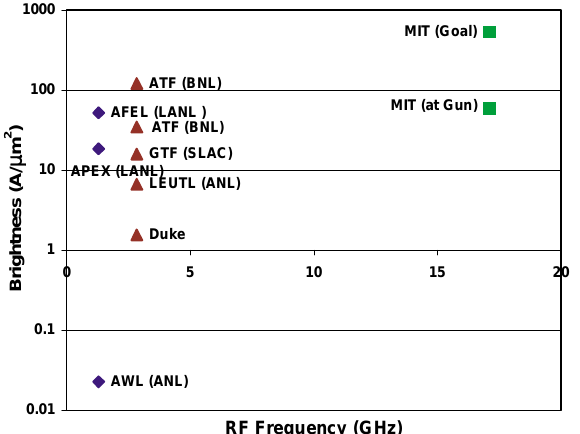
FIG. 12. (Color) Beam brightness for various RF photoinjectors. Both the beam brightness obtained with the 1.5 cell MIT gun as well as the goal of 800 A (cid:1)(cid:2) p mm mrad (cid:3) 2 are